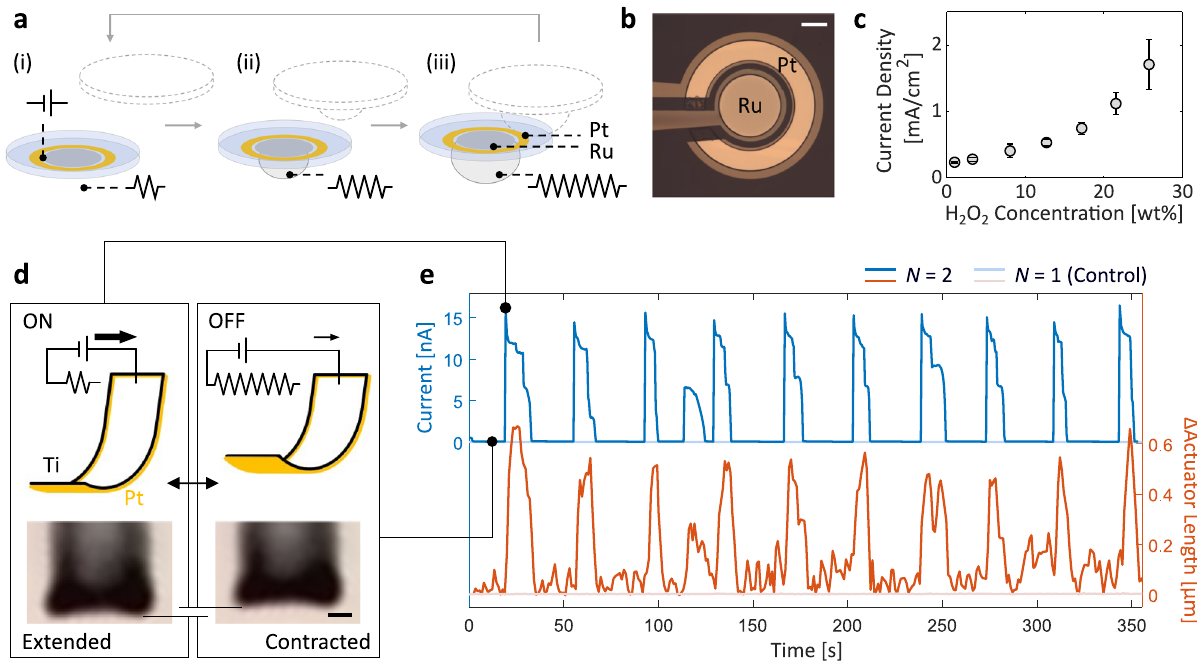
Fig. 4 | Self-organised oscillation powers a microrobotic arm. a Schematics of the generation of an oscillatory electrical current from chemomechanical beating. The pair of metals (Pt – Ru or Pt – Au) patterned on a polymer base constitute the electrodes of a H 2 O 2 fuel cell, which serves as an on-board voltage source. The periodic bubble growthand collapse in a beating system separatelymodulates the electrical resistance between the electrodes, leading to an oscillatory current. b OpticalmicrographofatypicalPt-Rufuelcellparticle.Theentiresurface,lessthe electrode area, is passivated with a thin layer of insulating SU-8 polymer (shaded). The metallic leads on the left are not necessary for device operation and are